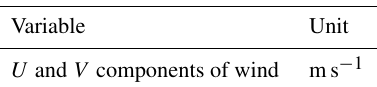
Table 8. WRF upper-air parameters (with units) at 5 heights (40, 60, 80, 100, 120m) archived by ICHEC at 1h intervals.